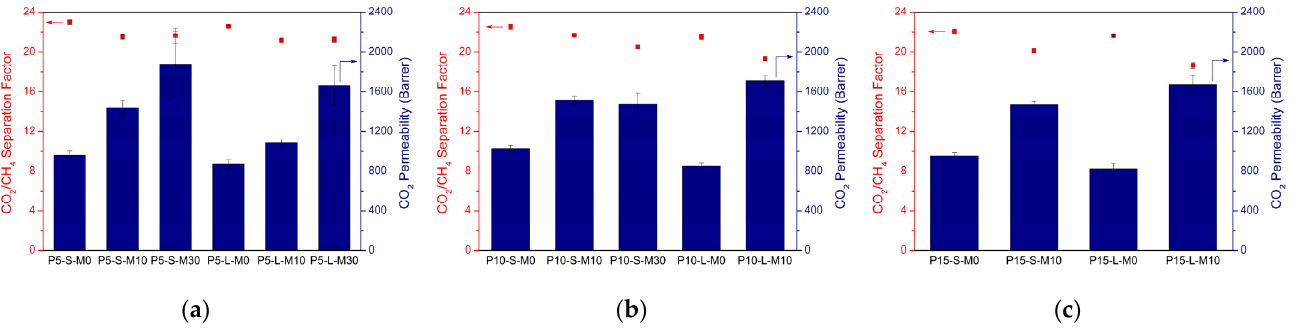
Figure 2. Mixed-gas CO 2 /CH 4 separation factors (dots) and CO 2 permeabilities (bars) of unfilled 6FDD membranes and corresponding MMMs cast from ( a ) 5 wt.%, ( b ) 10 wt.%, or ( c ) 15 wt.% polymer solutions with different combinations of synthesis parameters. “PX” represents the polymer concentration of the solutions while “S” and “L” indicate the small and large solution volume, respectively. “MX” corresponds to the amount of MOF loading (wt.%).